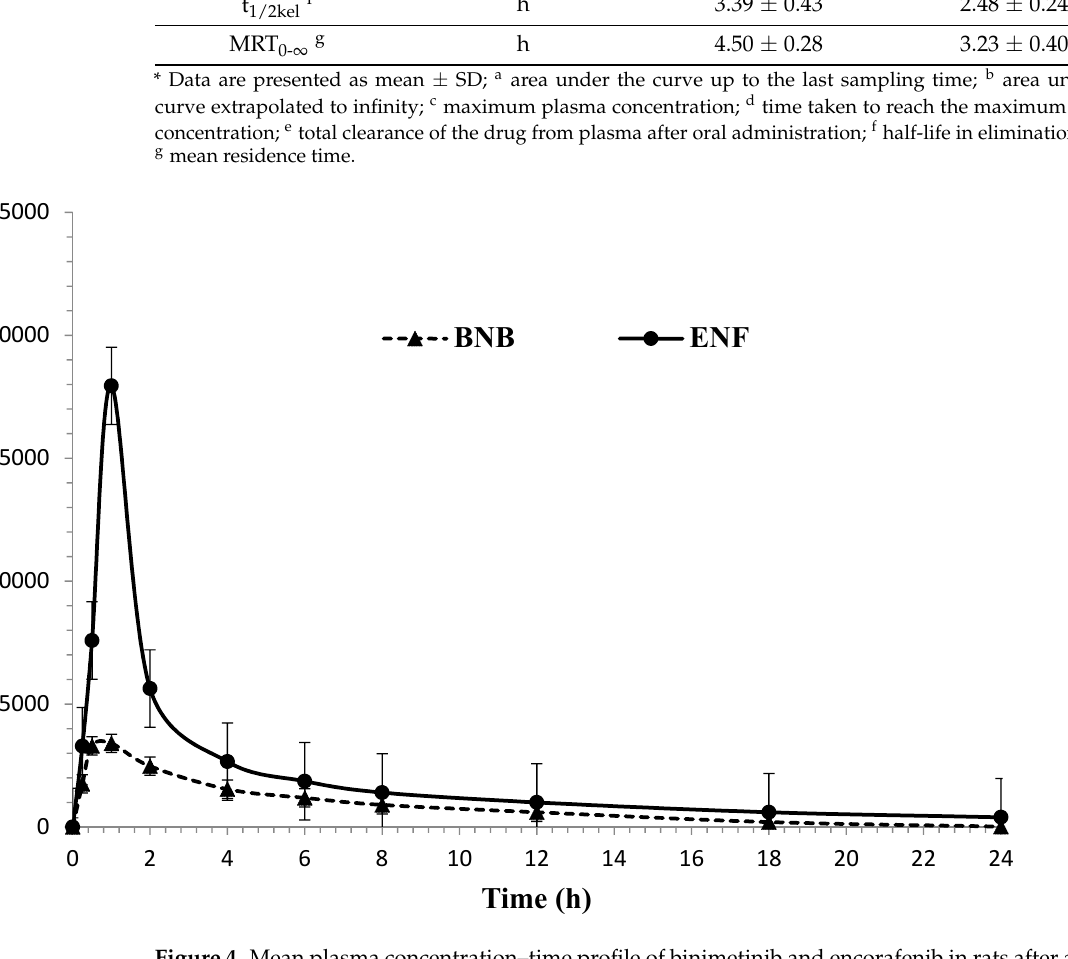
Figure 4. Mean plasma concentration–time profile of binimetinib and encorafenib in rats after a single oral dose of 3.8 mg/kg binimetinib and 20 mg/kg encorafenib (n = 6, mean ± SD). Table 7. The pharmacokinetic parameters of binimetinib and encorafenib in rat plasma after oral administration of 3.8 mg/kg binimetinib and 20 mg/kg encorafenib (n = 6, mean ± SD).